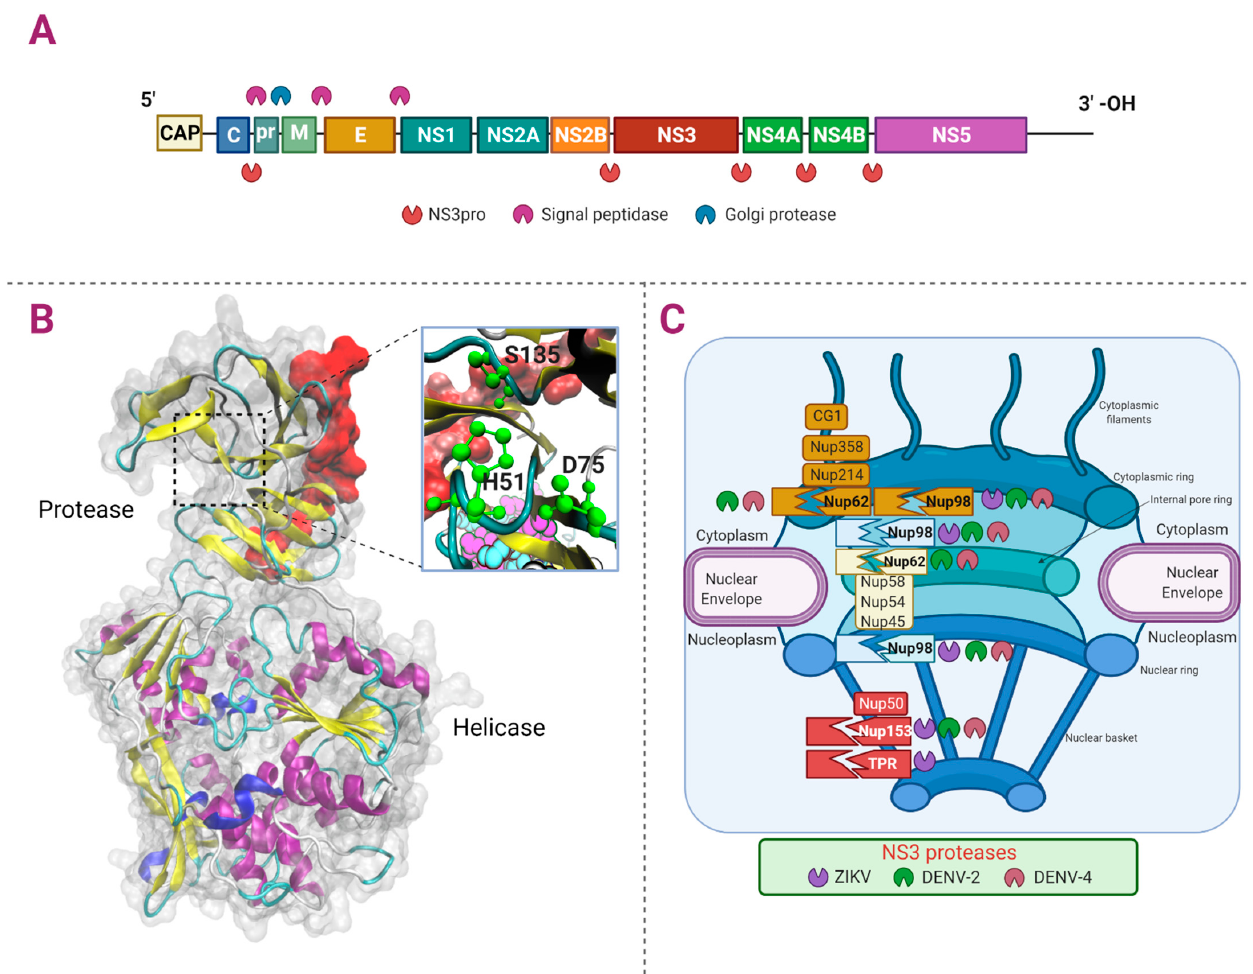
Figure 3. Proteolytic targets of Flavivirus NS3. Panel ( A ) shows the Flavivirus RNA genomic organization encoding three structural and seven non-structural proteins. Panel ( B ) shows the NS3 from DENV-4 (Protease and Helicase in New Cartoon (helix- α in purple, 3 10 helix in blue, β -sheets in yellow, β -bridge in tan, and turn in cyan), and the zoom of the catalytic triad H51, D75, and S135 in green)). Also, cofactor NS2B (red) is shown (PDB ID: 2VBC). Panel ( C ) shows the cleavages of Nups by NS3pro from DENV and ZIKV.